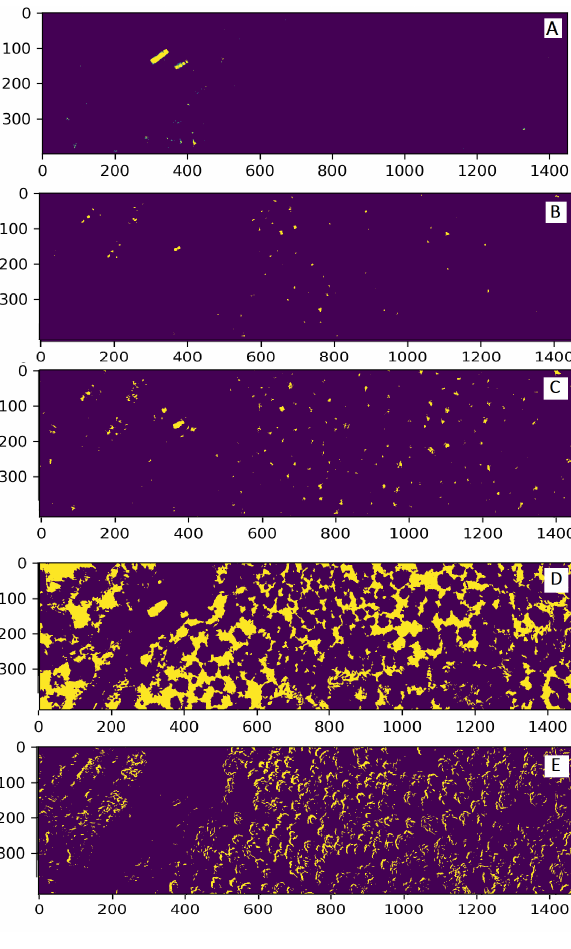
Figure 11: The anomaly detection maps of the forest data. A: MLM, implemented with cosine distance metric, using variance and one threshold (Table 3, image A). The size of the X was 2500, and R was 250. B: One-Class-SVM, C: Isolation forest, D: Global RX, E: Local RX. The anomaly maps of the reference methods are originally from the (P¨ol¨onen et al.,